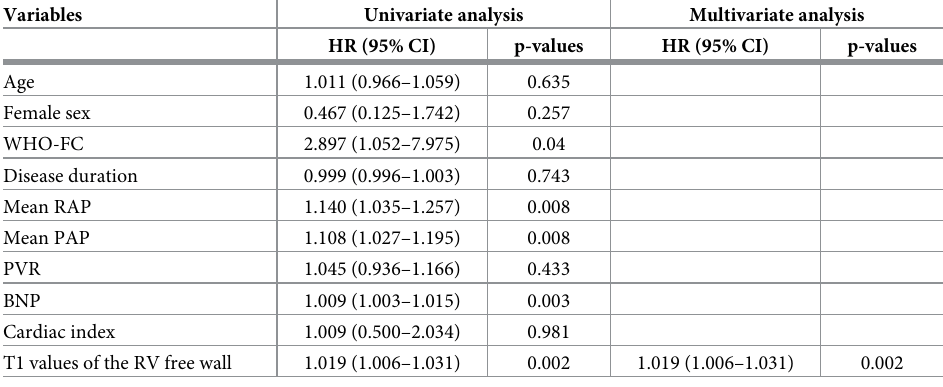
Abbreviations: BNP, brain natriuretic peptide; CI, confidence interval; HR, hazard ratio; PAP, pulmonary arterial pressure; PVR, pulmonary vascular resistance; RAP, right atrial pressure; RV, right ventricle; WHO-FC, World Health Organization functional